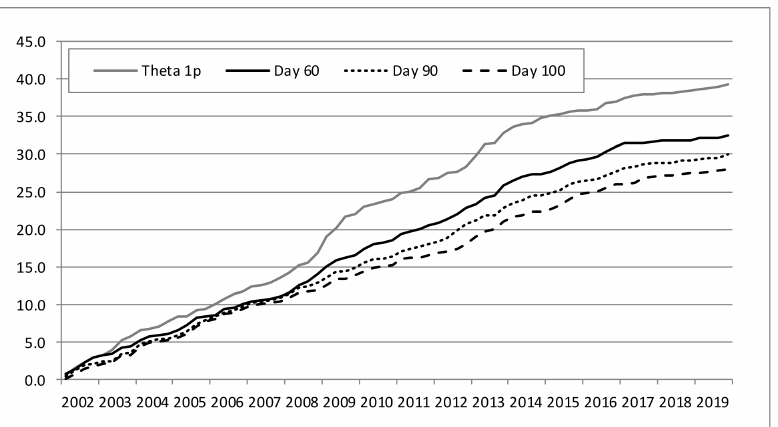
Figure 6. Cumulative absolute out-of-sample forecast error of the median of Models 1 to 6 given the data available at days 60, 90 and 100 of the current quarter compared with the one-step-ahead Theta forecast (percentage points,